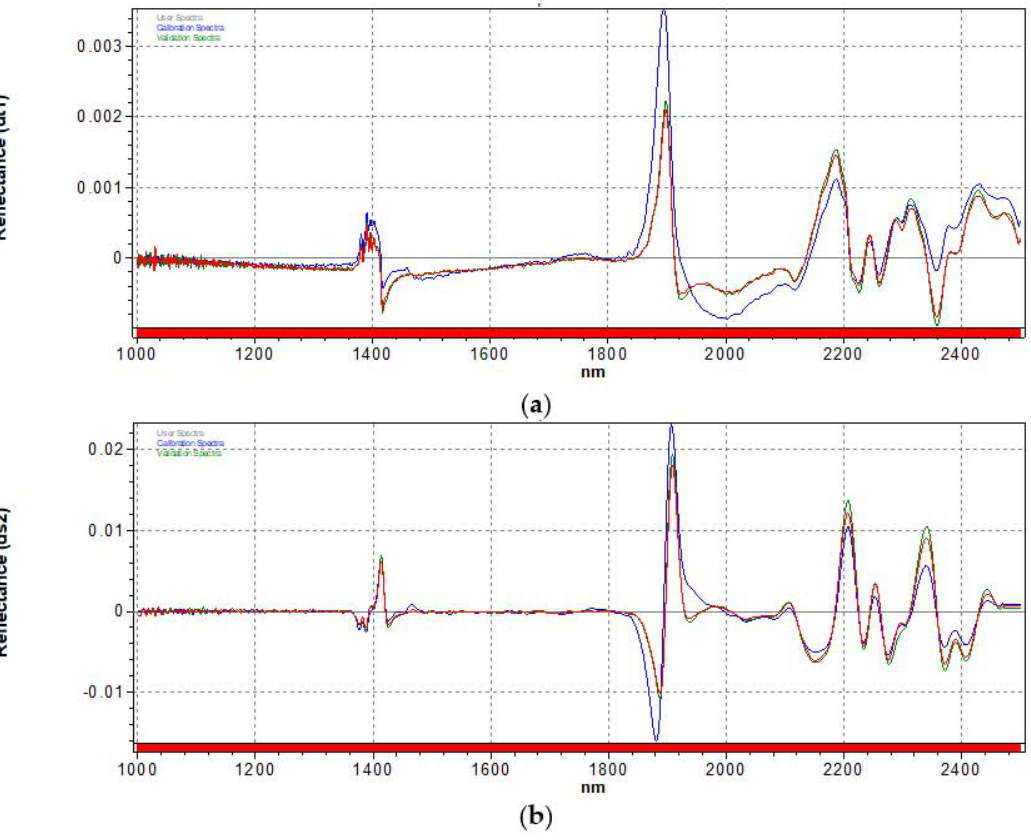
Figure 5. Pre-processing treatment on average NIR spectra calculated separately from the WS (blue spectrum), DS (red spectrum) and GSS (green spectrum): effects of ( a ) first derivative; ( b ) second